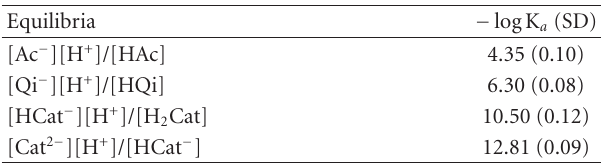
Table 2: Dissociation constants of major groups in natural melanin ∗